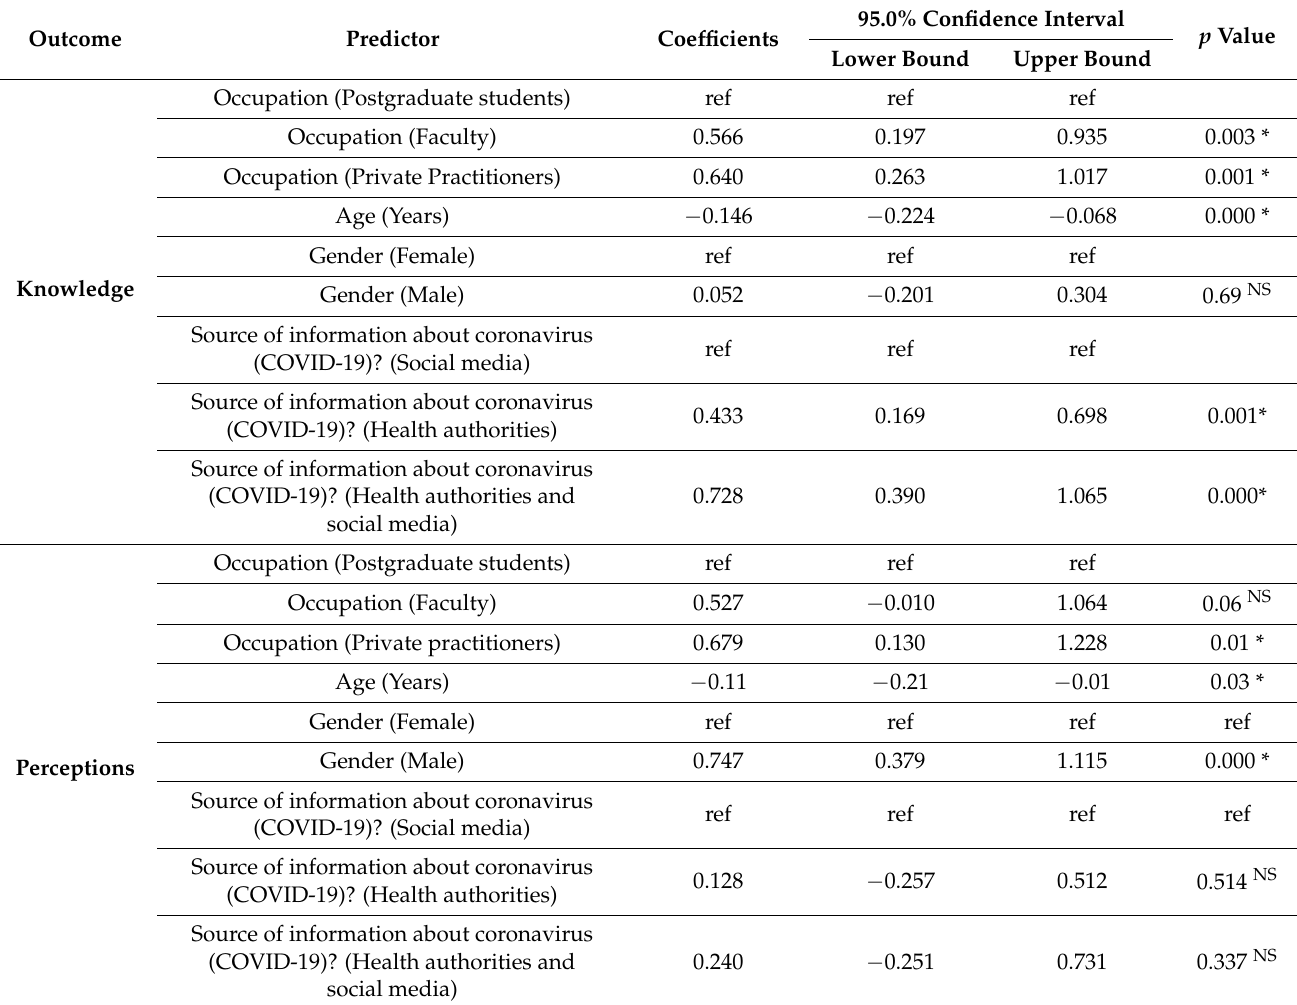
Table 4. The multivariate linear regression analysis used the association between demographic variables and the pediatric dentists’ knowledge and perception